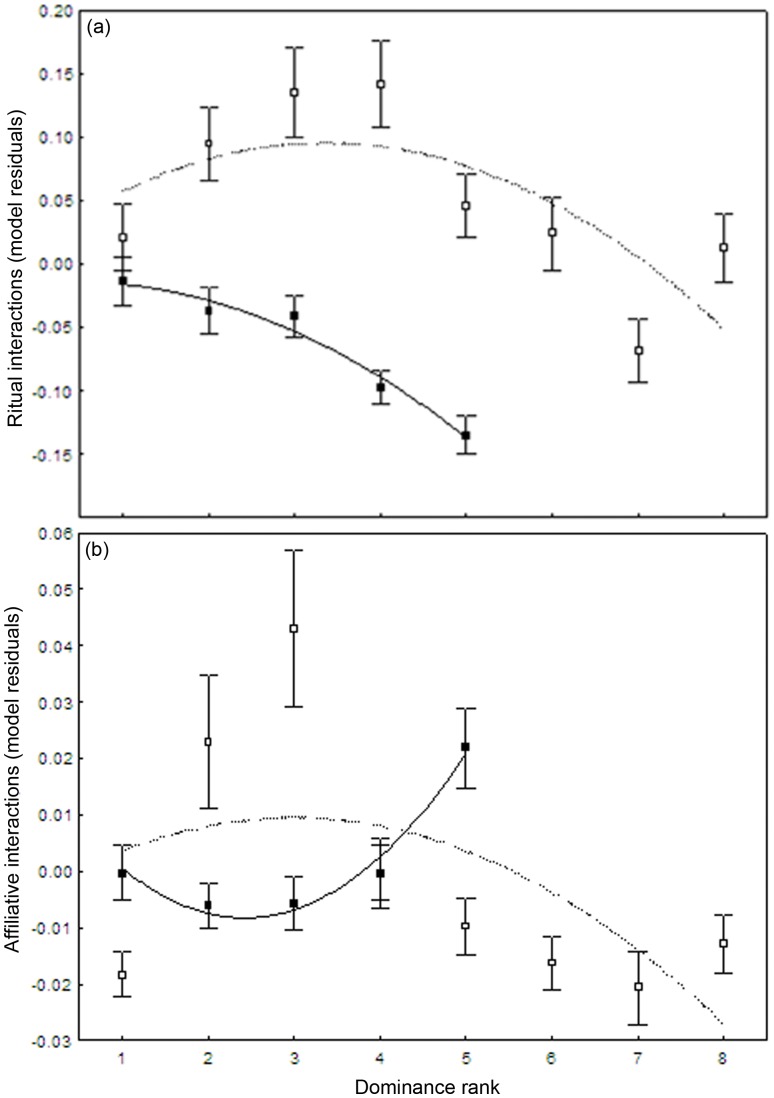
Relationship between the frequency of ritual (a) and affiliative (b) interactions per hour (model residuals controlled for the effect of the time after integration) and the dominance rank of stallions in 2009 (black square) and 2010 (empty squares; mean±SE per rank).The best fit (quadratic) is indicated with a solid line for 2009 and dashed line for 2010 data. Residuals represented stallions that had more interactions than predicted by the time after integration. Higher dominance ranks indicate higher-ranking individuals.